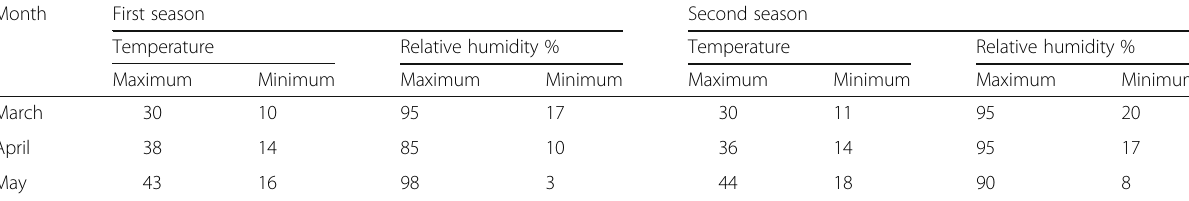
Table 1 Average of monthly maximum and minimum air temperature and relative humidity during the two season of study